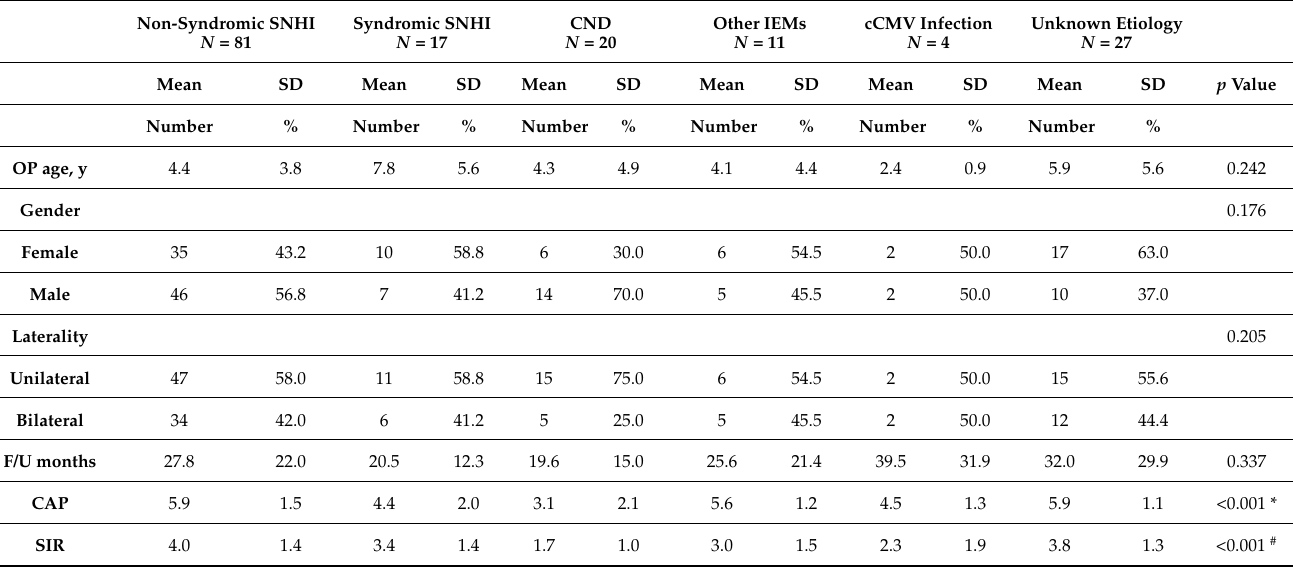
Table 2. Comparison of demographic characteristics and outcome performances according to different etiologies.